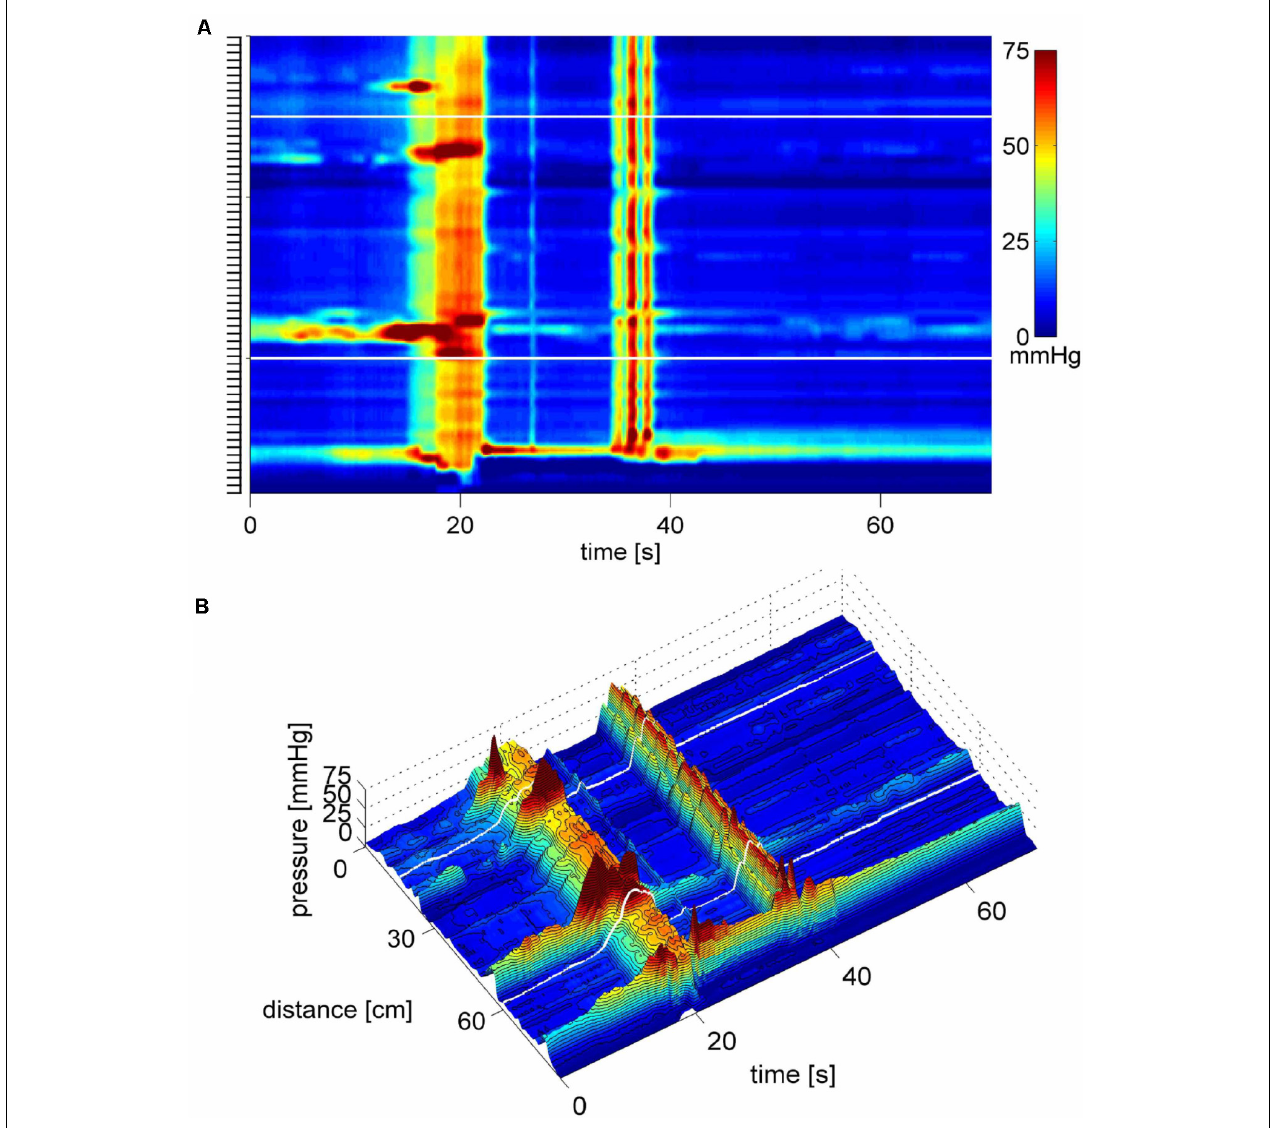
FIGURE 10 | SPWs consist of multiple high frequency pressure waves. (A) Two SPWs appear in response to the meal. They can be seen as consisting of clusters of high frequency multiple pressure waves, suggesting that they may be caused by a cluster of rapidly propagating circular muscle contractions as was shown to be the case in the rabbit colon (Quan et al., 2017). (B) 3D image of (A)